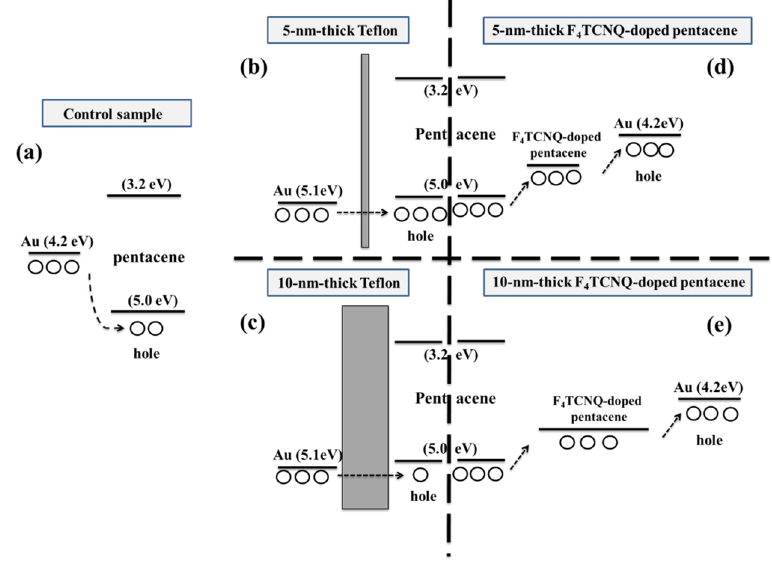
Figure 6. Band diagram of top ‐ contact (TC) pentacene ‐ based OTFTs with various interlayer thicknesses ( a ) control sample, ( b ) 5 ‐ , and ( c ) 10 ‐ nm ‐ thick Teflon and ( d ) 5 ‐ , and ( e ) 10 ‐ nm ‐ thick F 4 TCNQ ‐ doped pentacene.